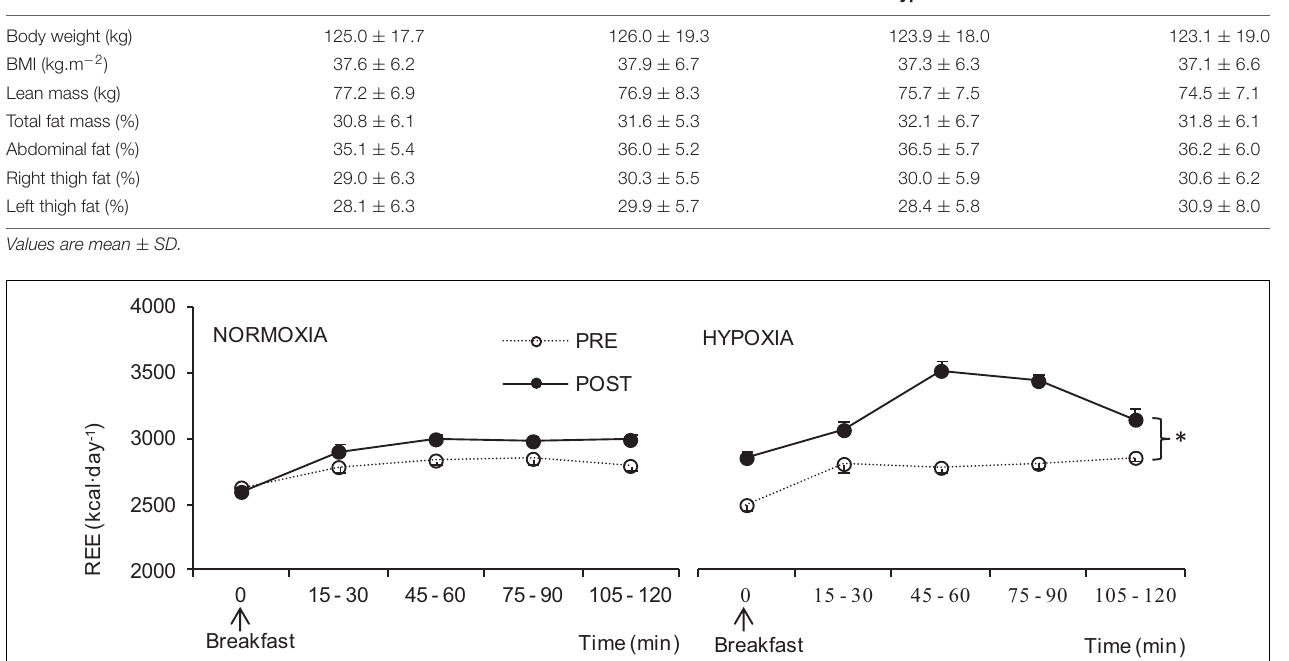
However, in the absence of any control groups or control trials extent to which either the hypoxia per se or the physical activity contributed to the weight